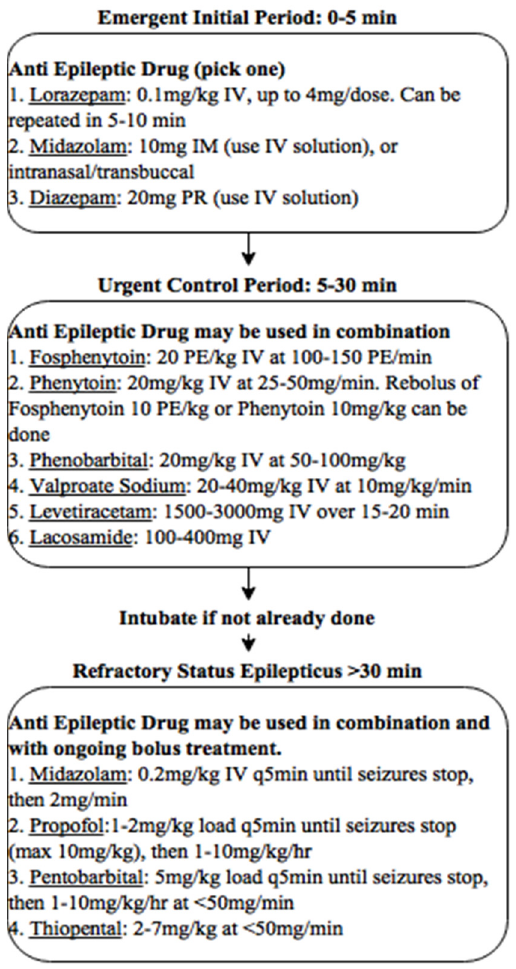
Figure 1. Suggested management strategy for patients.